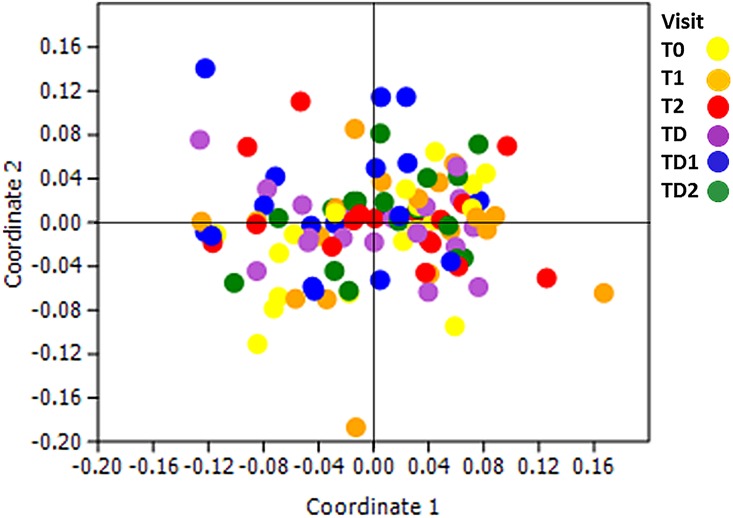
Non-metric multidimensional scaling plot based on the three-dimensional Bray-Curtis similarity index by time.The plot consists of samples of all subjects (N = 19) who were present at all six time points. The stress for this plot is 0.1836.